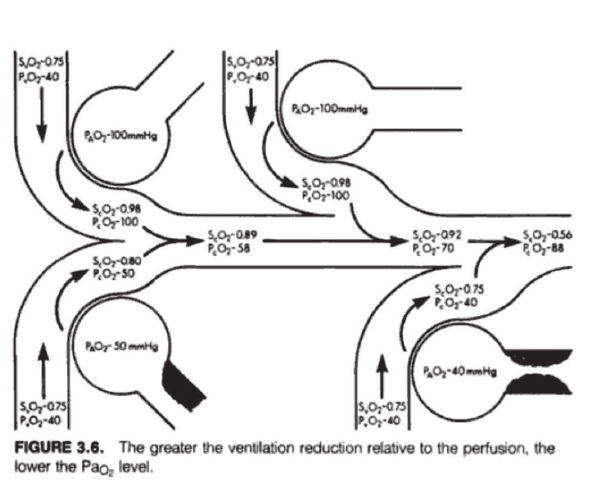
Fig. 2 - Distúrbio na relação ventilação-perfusão pulmonar, onde uma fração do fluxo de sangue pulmonar não estava devidamente ventilado